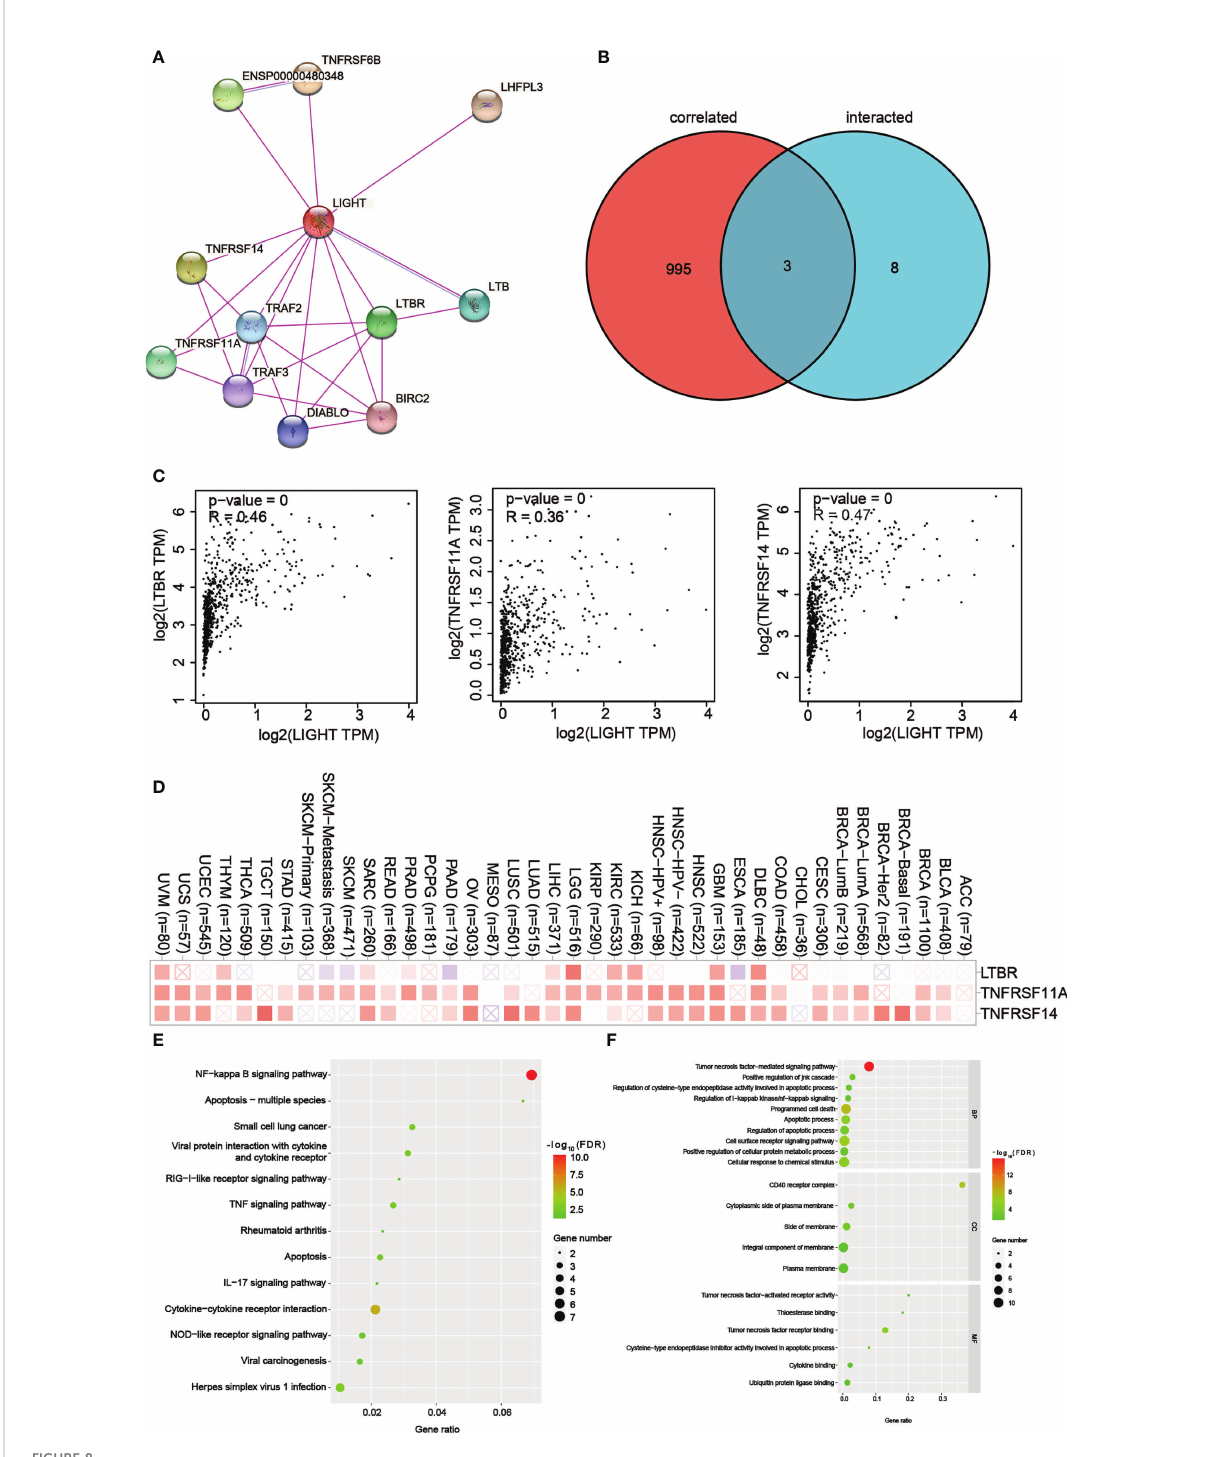
FIGURE 8 LIGHT-related gene enrichment analysis. (A) We fi rst obtained the available experimentally determined LIGHT-binding proteins using the STRING tool. (B) An intersection analysis of LIGHT binding (from STRING) and correlated genes (from GEPIA2) was conducted. (C) Expression correlation between LIGHT and selected targeting genes, including LTBR, TNFRSF11A and TNFRSF14. (D) The corresponding heatmap data in the detailed cancer types are displayed. (E) Based on the LIGHT-binding proteins, KEGG pathway analysis was performed. (F) (The molecular function data in GO analysis are also